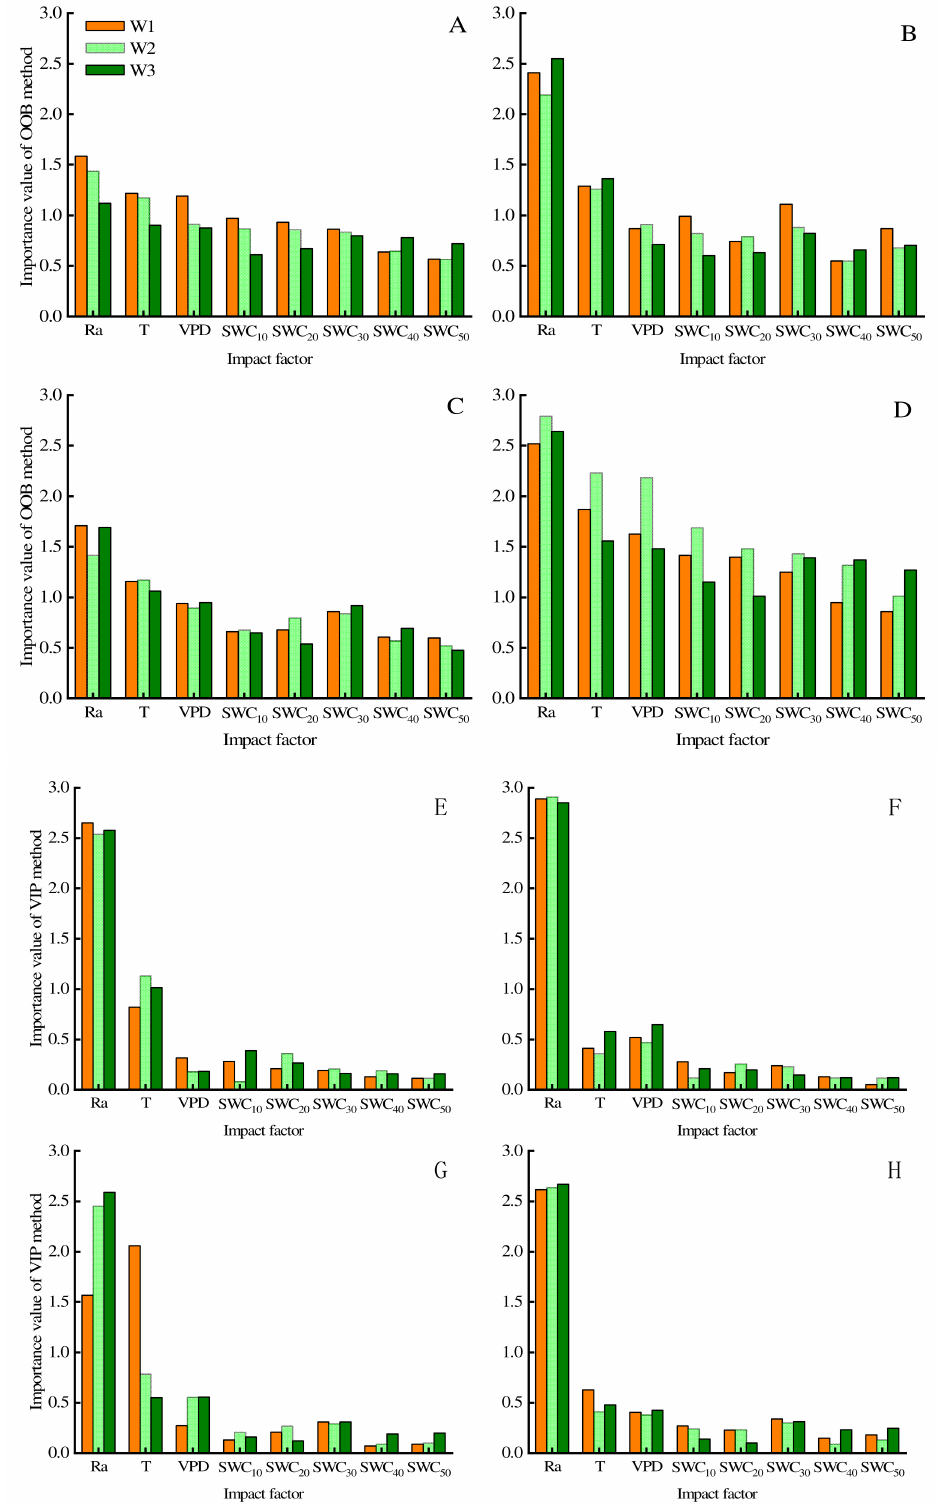
Figure 6. ( A ) Importance of predictor variables in the RF model during the shoot growth stage; ( B ) importance of predictor variables in the RF model during the fruit expansion stage; ( C ) importance of predictor variables in the RF model during the veraison and maturity stage; ( D ) importance of predictor variables in the RF model during the whole growth period; ( E ) importance of predictor variables in the PLS model during the shoot growth stage; ( F ) importance of predictor variables in the PLS model during the fruit expansion stage; ( G ) importance of predictor variables in the PLS